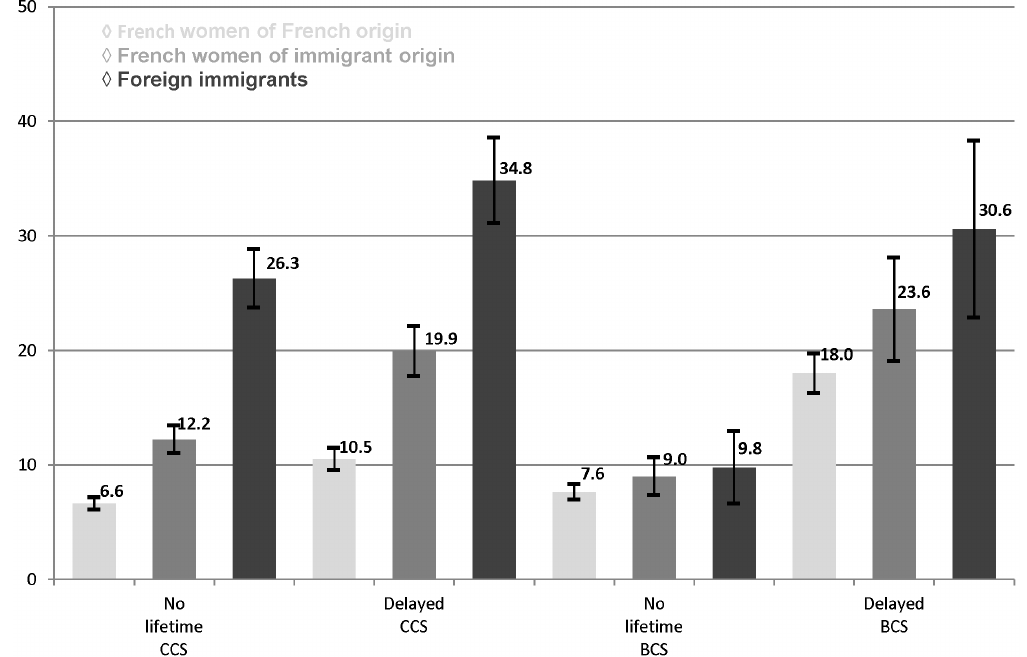
Figure 1. Standardized prevalence of delayed and no lifetime screening according to the women’s immigration status.